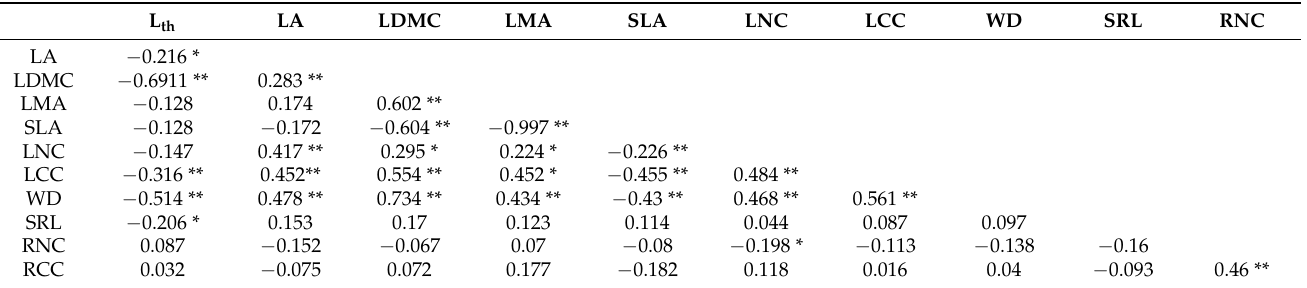
Table 3. Pearson correlation analysis of functional traits for lianas and trees.